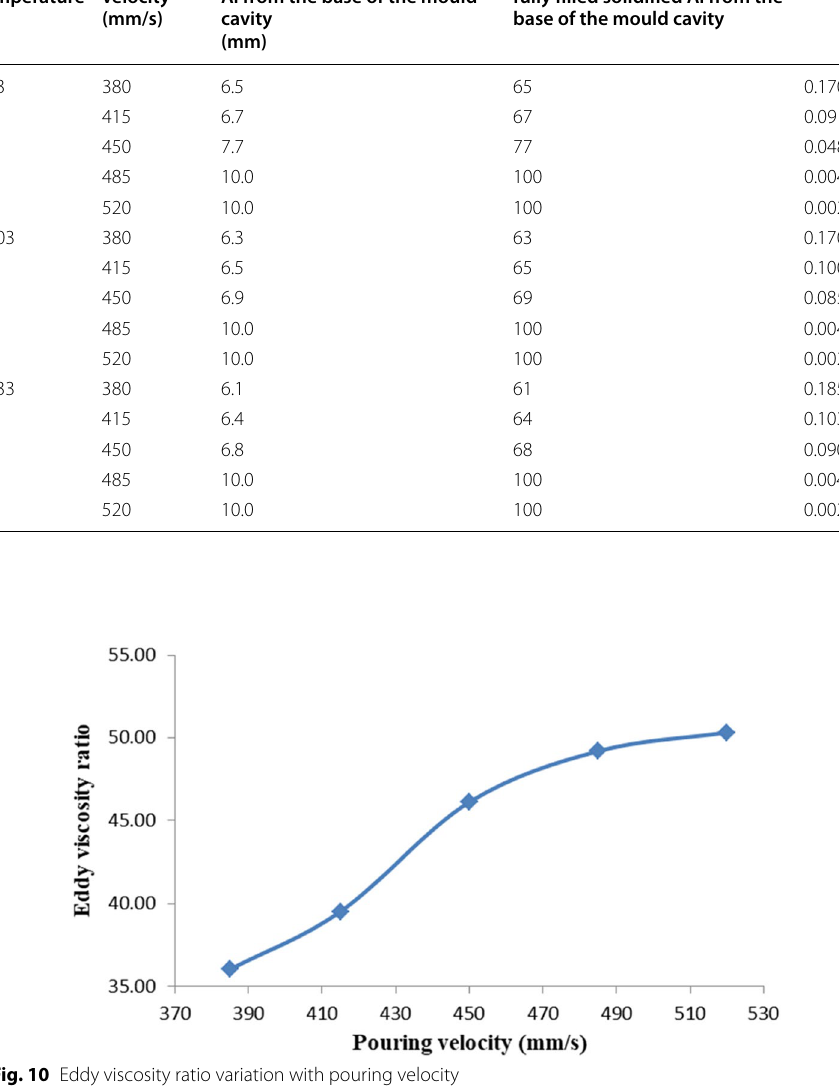
Table 3 Solid aluminium filled from the base of the mould cavity at different pouring parameters Pouring Pouring Length of fully filled solidified temperature velocity Al from the base of the mould (K) (mm/s) cavity (mm)